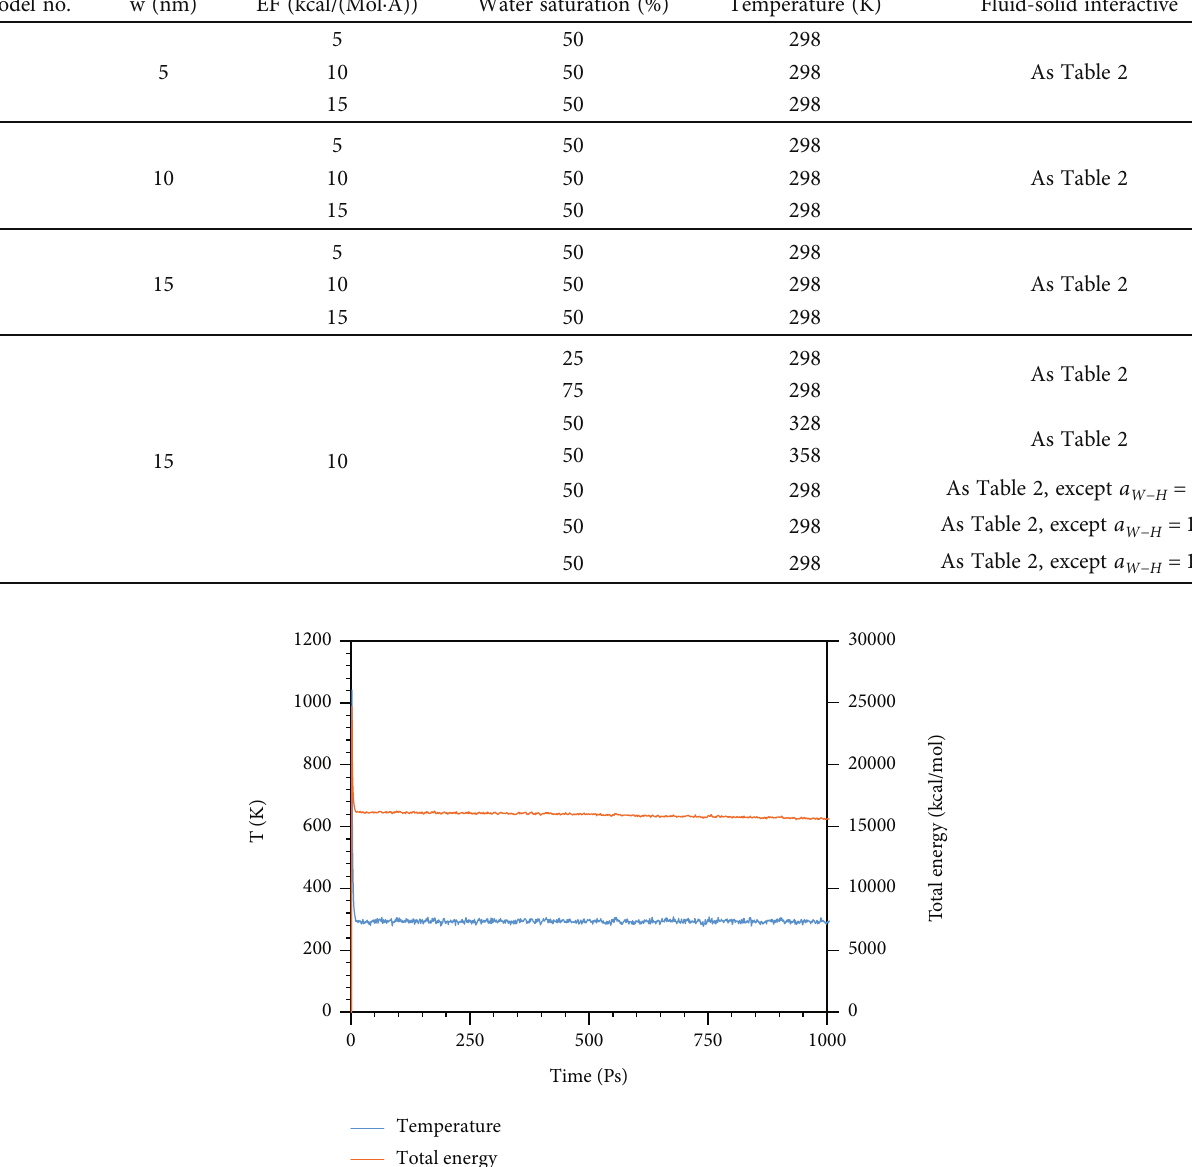
Figure 3: Temperature and energy curve of model